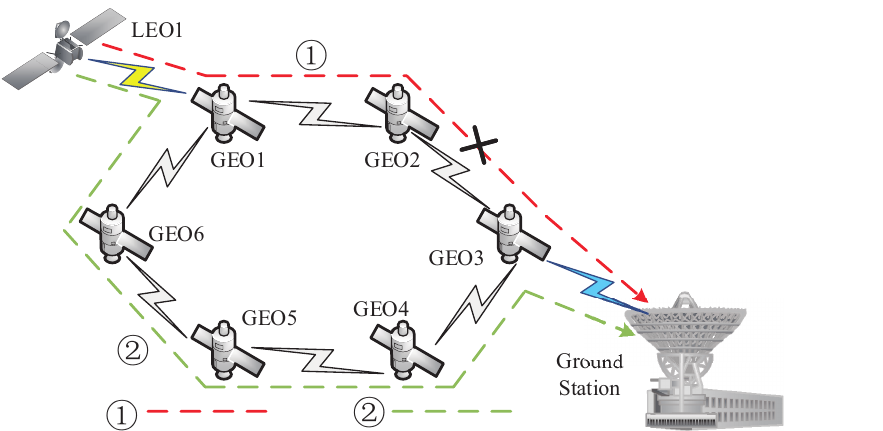
Figure 17. Topology of the IP routing scenario.